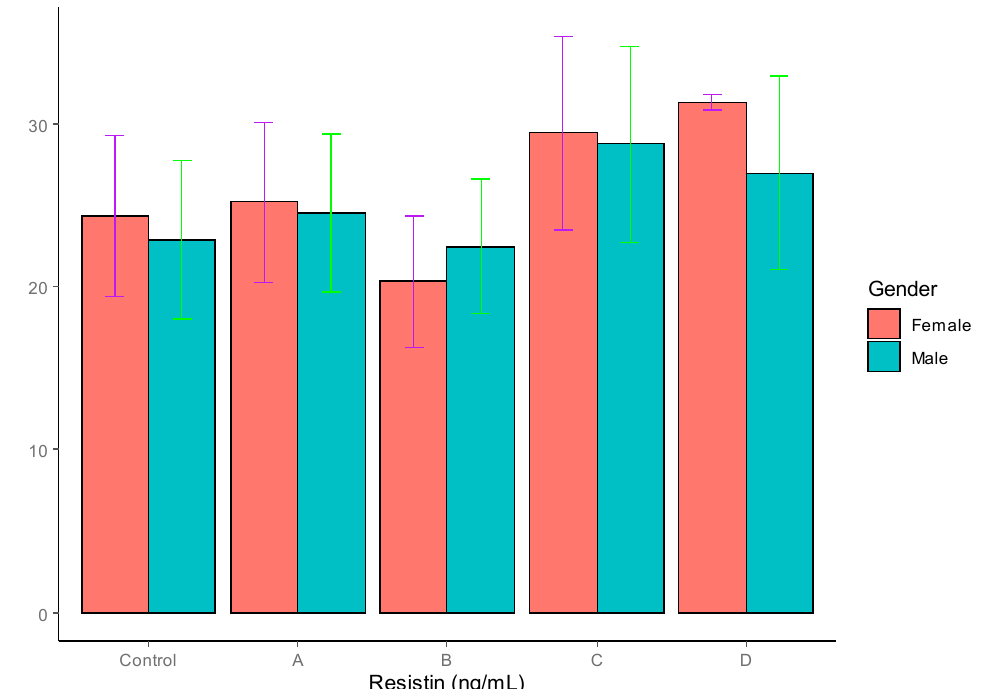
Figure 3. Serum resistin levels in T2DM patients and control groups (ng/mL). Visfatin: The results for serum visfatin are also depicted in Table 4 and graphically